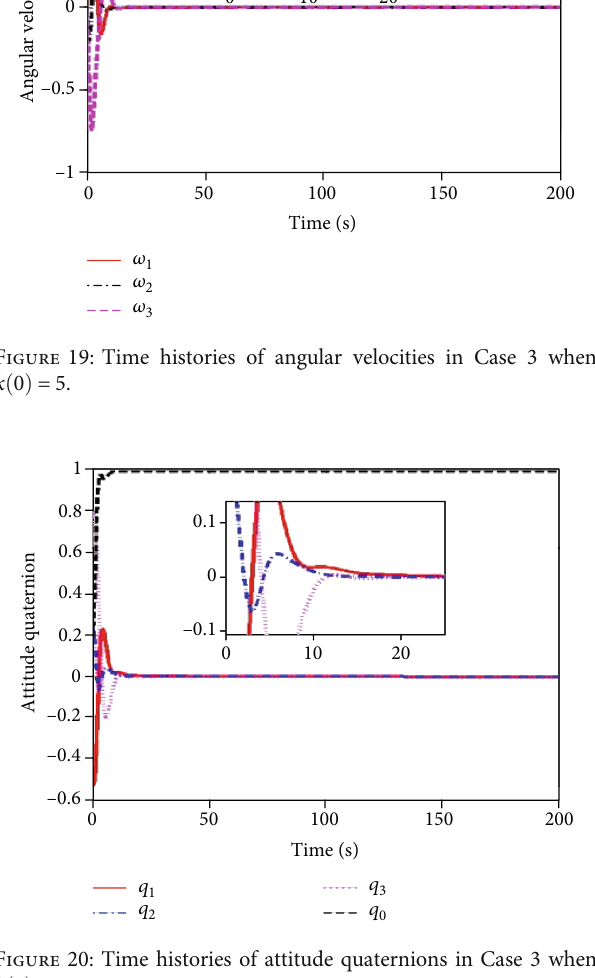
Figure 18: Time histories of attitude gain k in Case 3 when k ð 0 Þ = 0 : 5 .